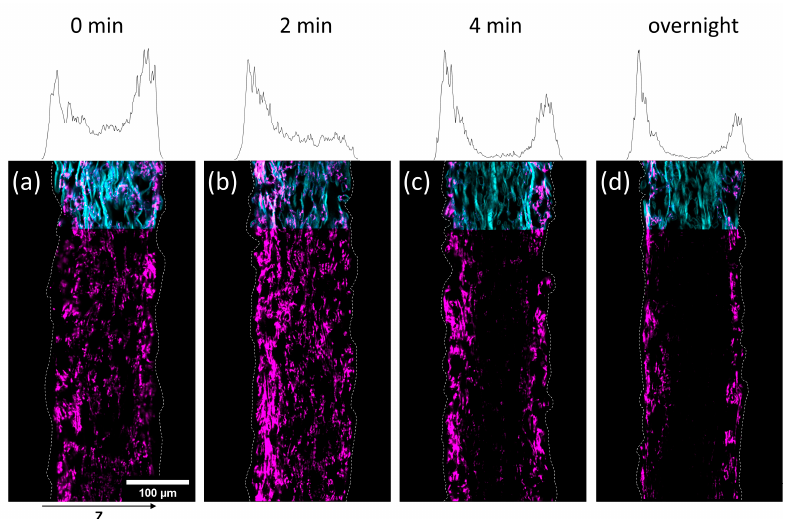
Figure 6. Cross-sections of paper samples modified with the photo-cross-linkable copolymer dis- solved in IPA (17 mg mL − 1 ), dried for different times (0 min ( a ); 2 min ( b ); 4 min ( c ); overnight ( d )) before freeze-drying to stop the evaporation (i.e., transport of the copolymer), acquired by fluo- rescence CLSM. The fibers are stained with FB (cyan color, outline continued) and the copolymer fluoresces due to the rhodamine B label (magenta). The left side of the images corresponds to the side that was facing upwards during the drying and UV-excitation of samples. The z-distribution of the copolymer fluorescence is shown above each cross-section. For easier comparison, the corresponding drying times are also noted.